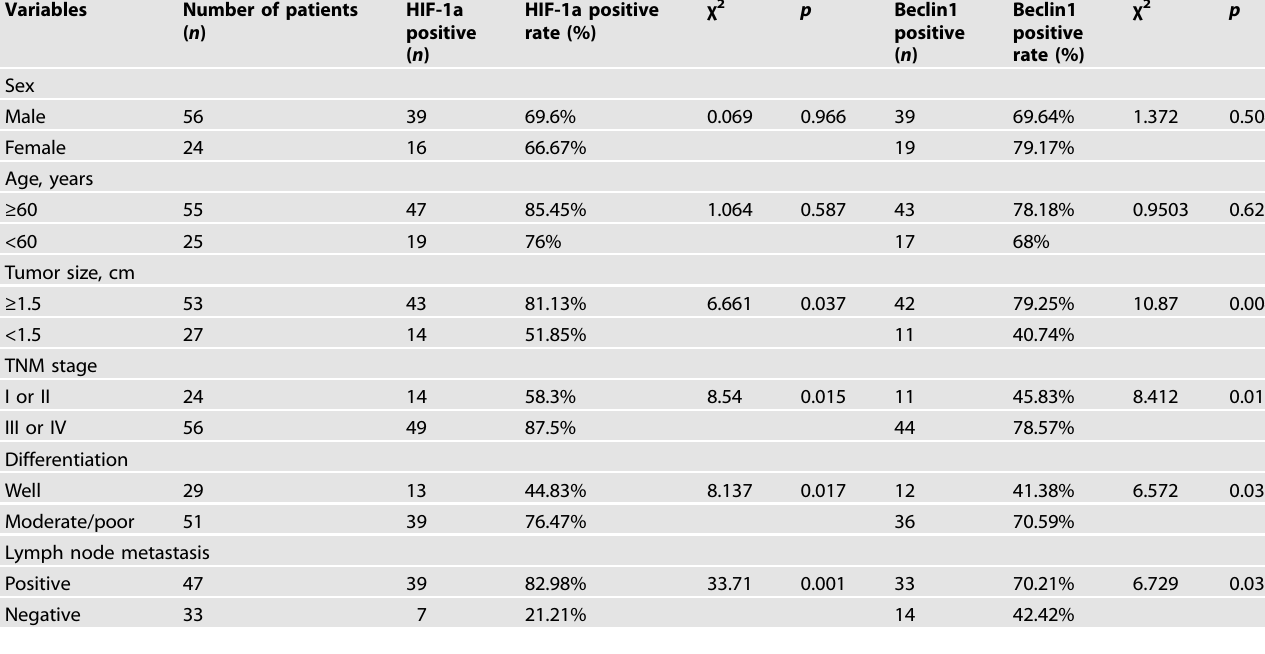
Table 1. Association between HIF-1 α , Beclin1 expression, and the clinical as well histopathological features of patients with oral squamous cell carcinoma ( n = 80).